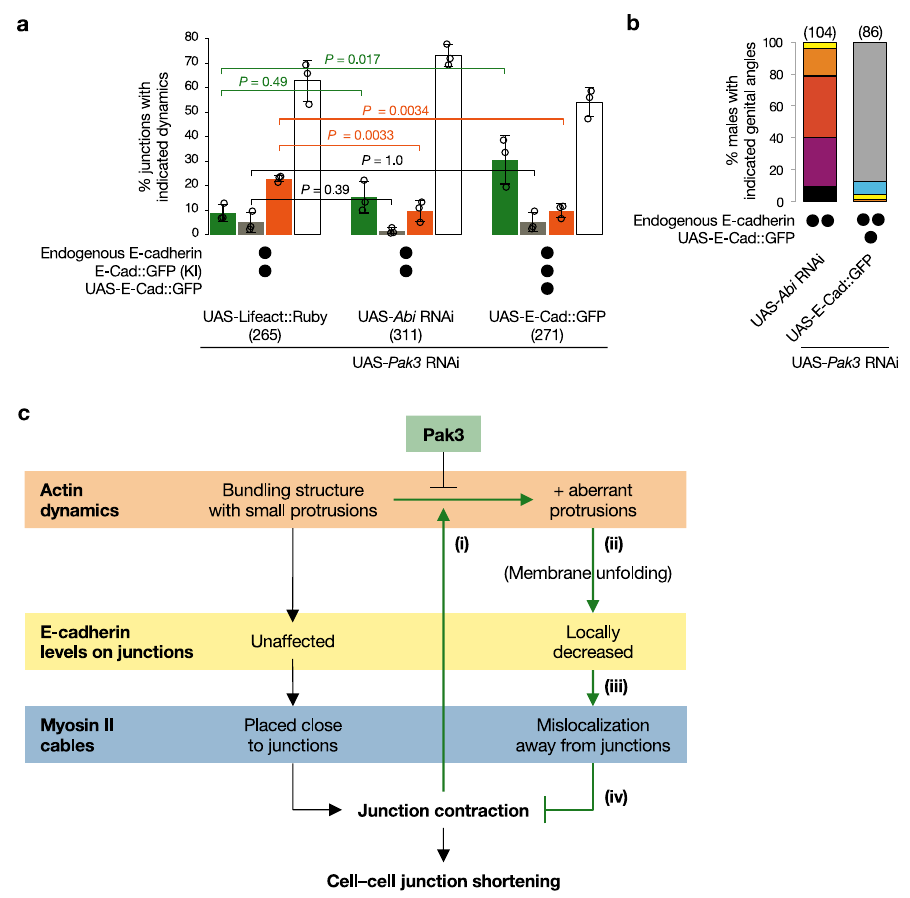
Fig. 5 E-cadherin overexpression rescues tissue dynamics. a Mean± S.D. of the percentages of junctions with the categorized dynamics. Bar colors correspond to Fig. 1e. Dots indicate the copy number of each E-cadherin allele. Parentheses, the number of examined junctions from n = 3 biologically independent pupae per genotype. P- values by two-tailed Dunnett ’ s test. b Percentages of male adult fl ies with genitalia angles indicated in Fig. 1b are shown. Dots indicate the copy number of each E-cadherin allele. Parentheses, the number of males examined. c A schematic illustration of Pak3-dependent junction contraction. (i) – (iv) indicate the negative feedback mechanism (green arrows, described in the “ Discussion ” section). Genotypes: a + /Y;E- Cad::GFP (KI)/UAS-Lifeact::Ruby;AbdB-Gal4, UAS-H2B::ECFP/UAS-Pak3 RNAi , + /Y;E-Cad::GFP (KI)/UAS-Abi RNAi;AbdB-Gal4, UAS-H2B::ECFP/UAS-Pak3 RNAi , and + /Y;E-Cad::GFP (KI)/UAS-E-Cad::GFP;AbdB-Gal4, UAS-H2B::ECFP/UAS-Pak3 RNAi ; b + /Y;UAS-Abi RNAi/ + ;AbdB-Gal4/UAS-Pak3 RNAi and + /Y;UAS-E-Cad::GFP/ + ;AbdB-Gal4/UAS-Pak3 RNAi . Source data are provided as a Source data fi